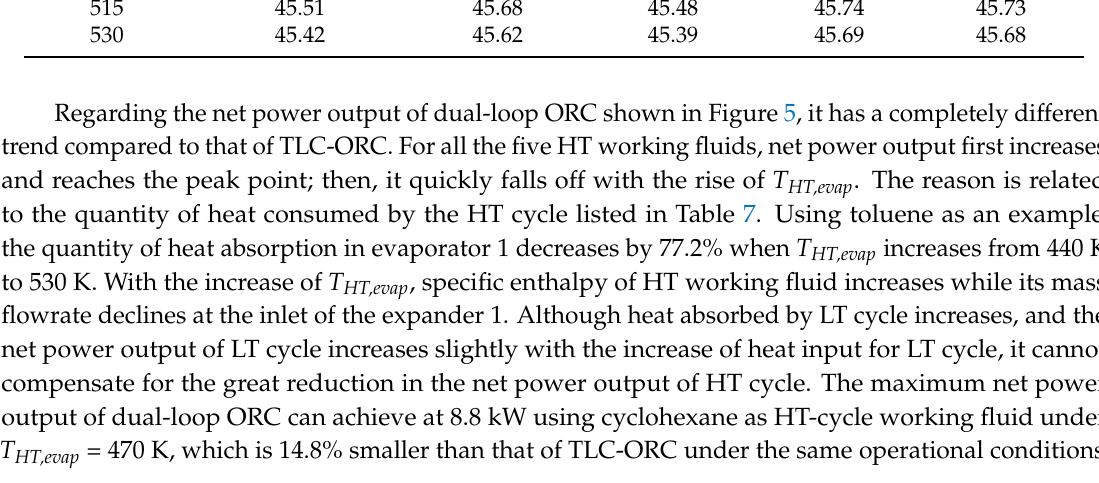
Table 7. Variation of heat consumed by the HT cycle of conventional dual-loop ORC system. T HT,evap